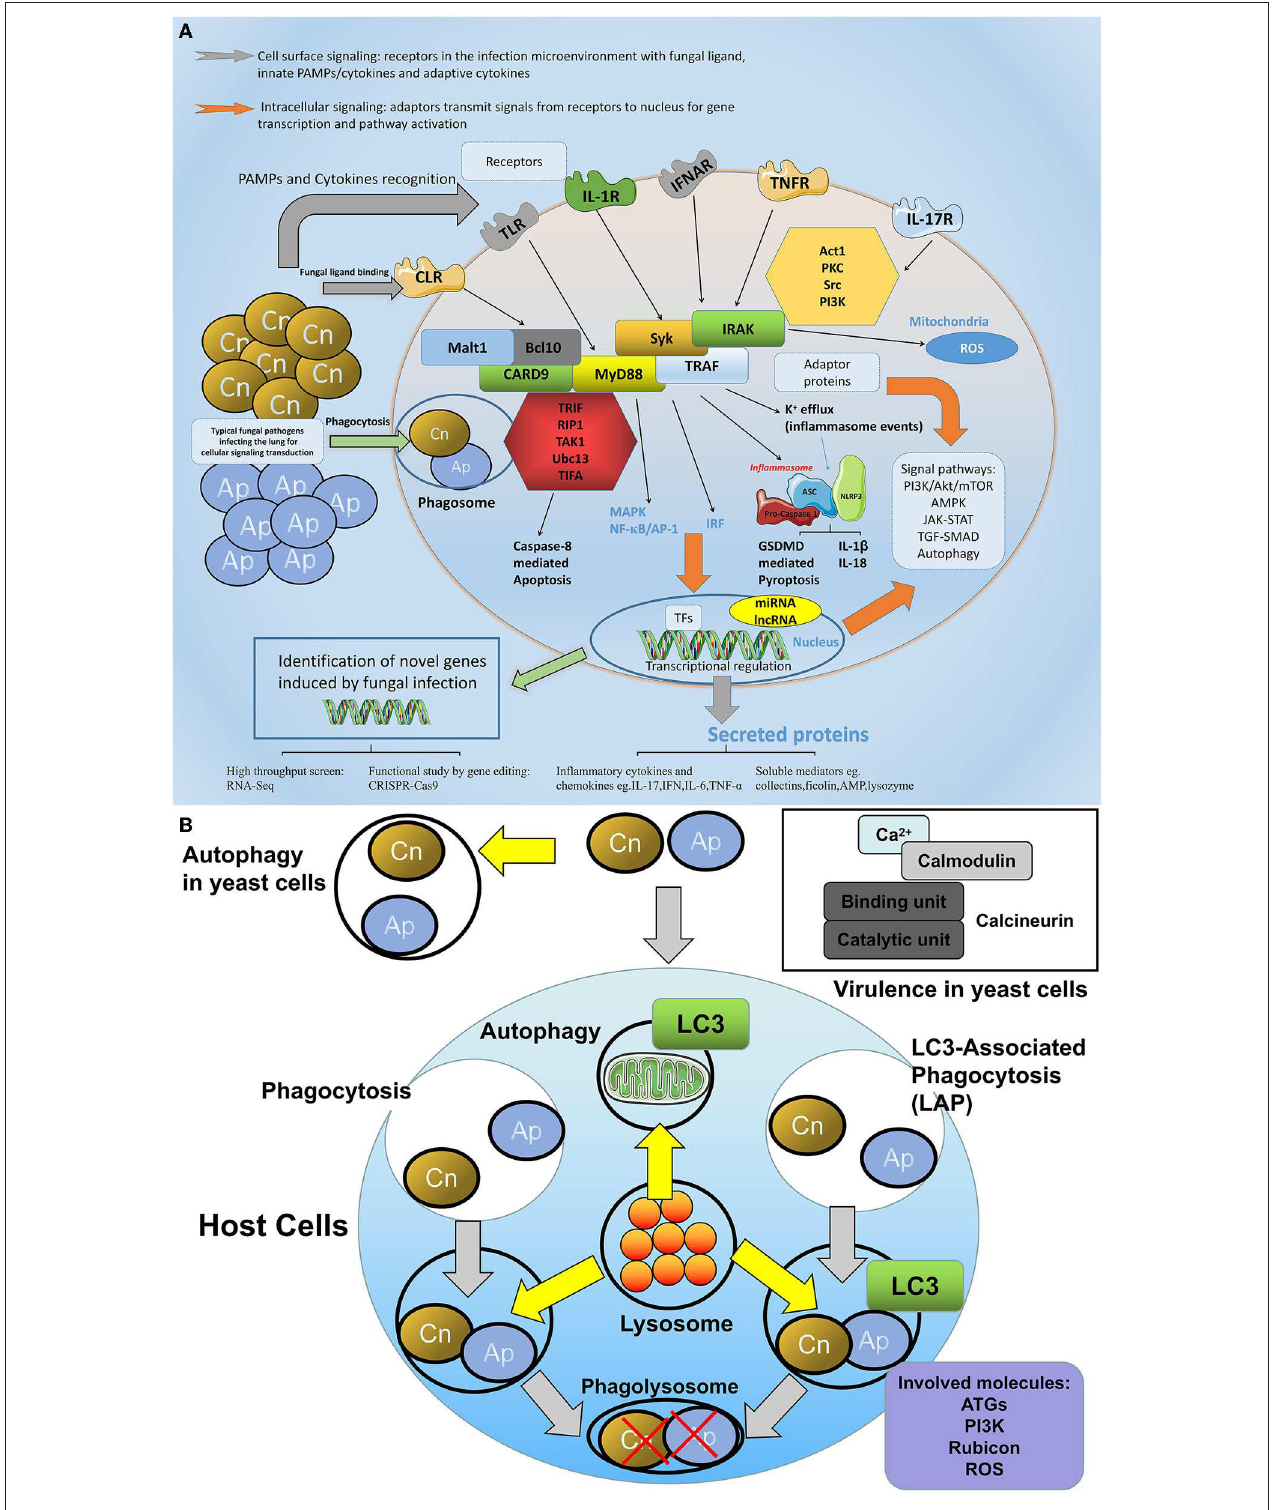
FIGURE 4 | The network of molecular defense against fungal infections in the lung. (A) General involved molecules and signal events in the aspects of cellular fungal infection. During fungal infection, various intracellular and extracellular molecules are involved in the host defense process. On the cell surface, receptors especially the